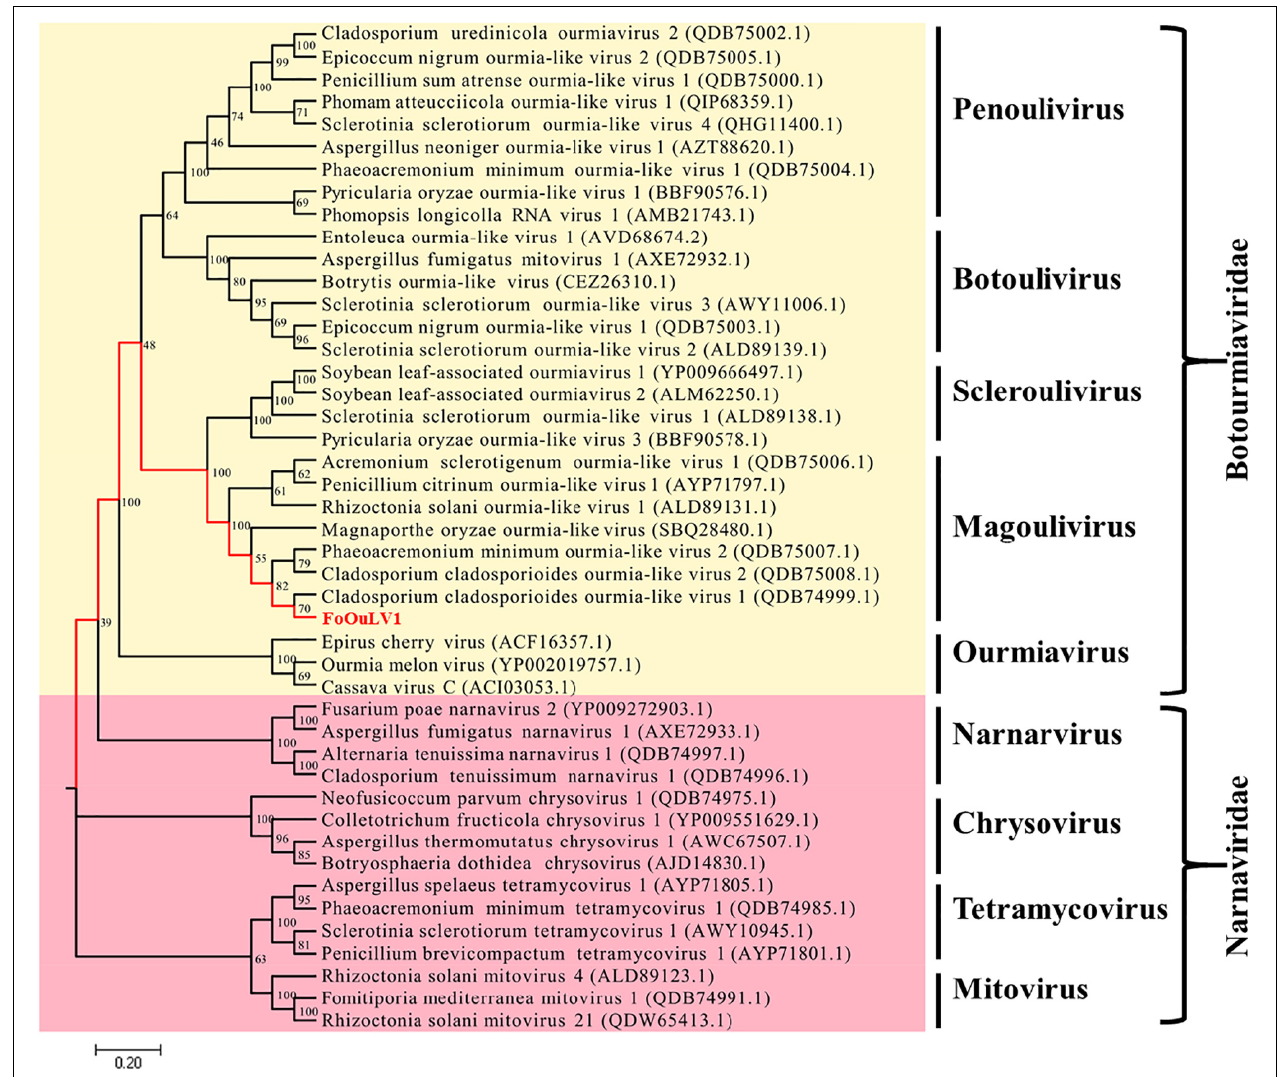
FIGURE 4 | Maximum likelihood phylogenetic tree based on the RdRps of FoOuLV1 and other related viruses. The phylogenetic analysis was generated using the MEGA7 software with 1,000 bootstrap replicates. The scale bar represents a genetic distance of 0.2.